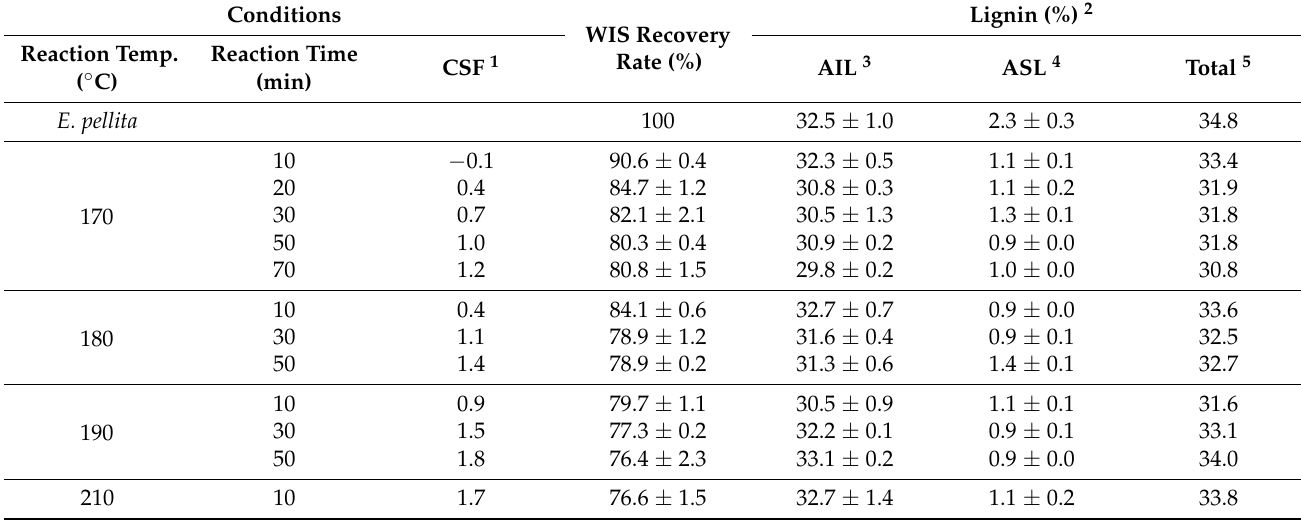
Table 1. Water-insoluble solid (WIS) recovery rate and lignin contents of the Eucalyptus pellita and the solid fractions obtained by liquid hot water (LHW) treatment.